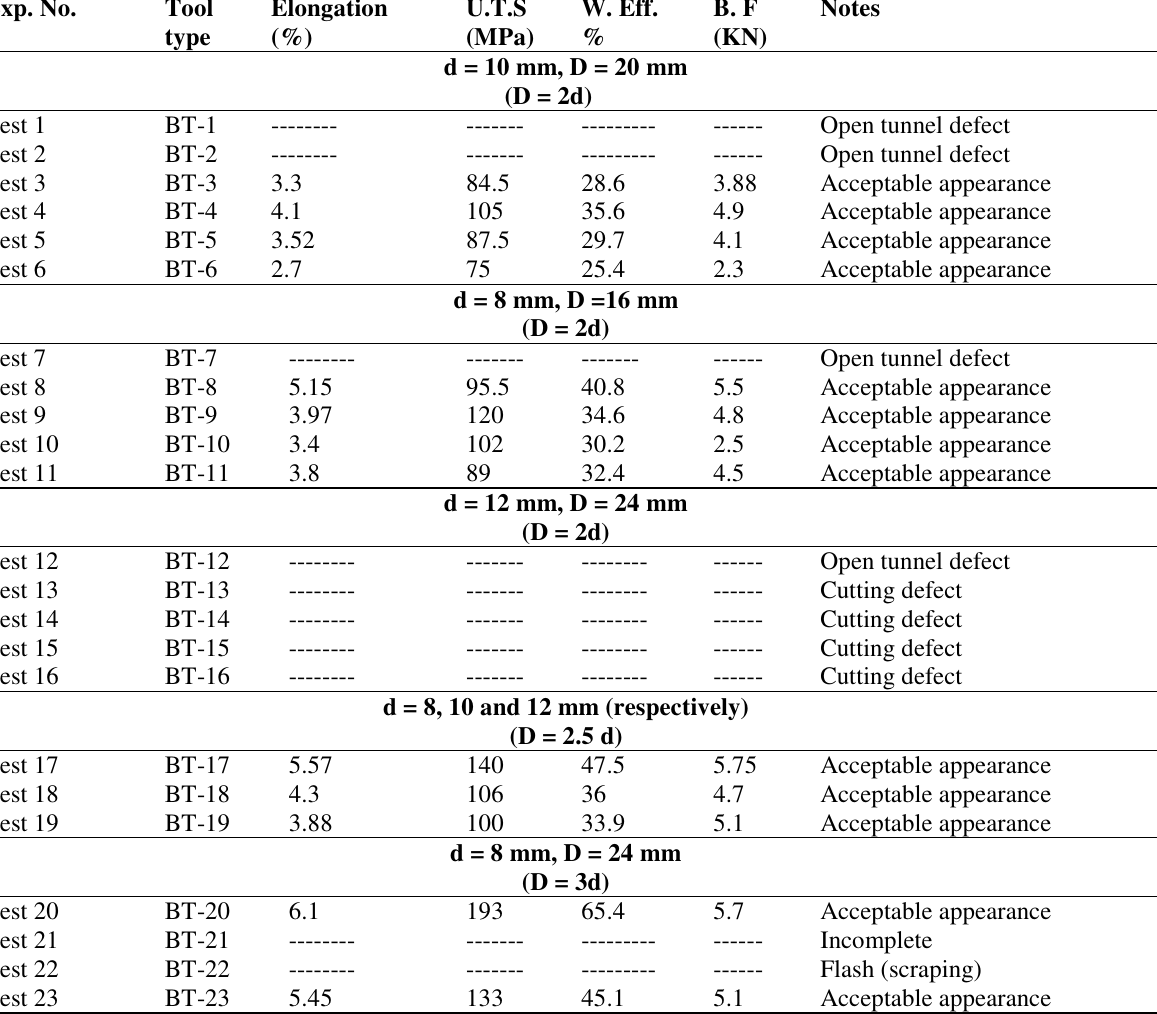
Table 5, Results of mechanical properties